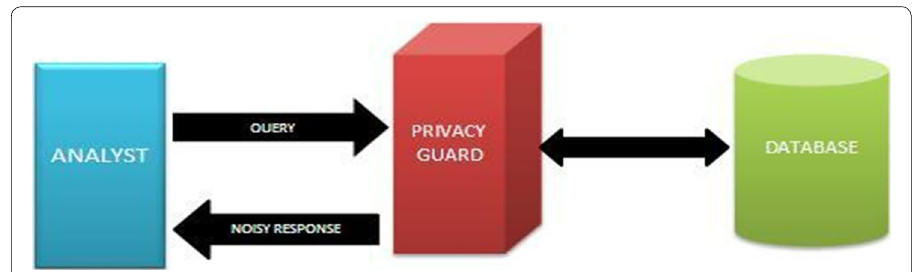
Fig. 1 Differential privacy mechanism